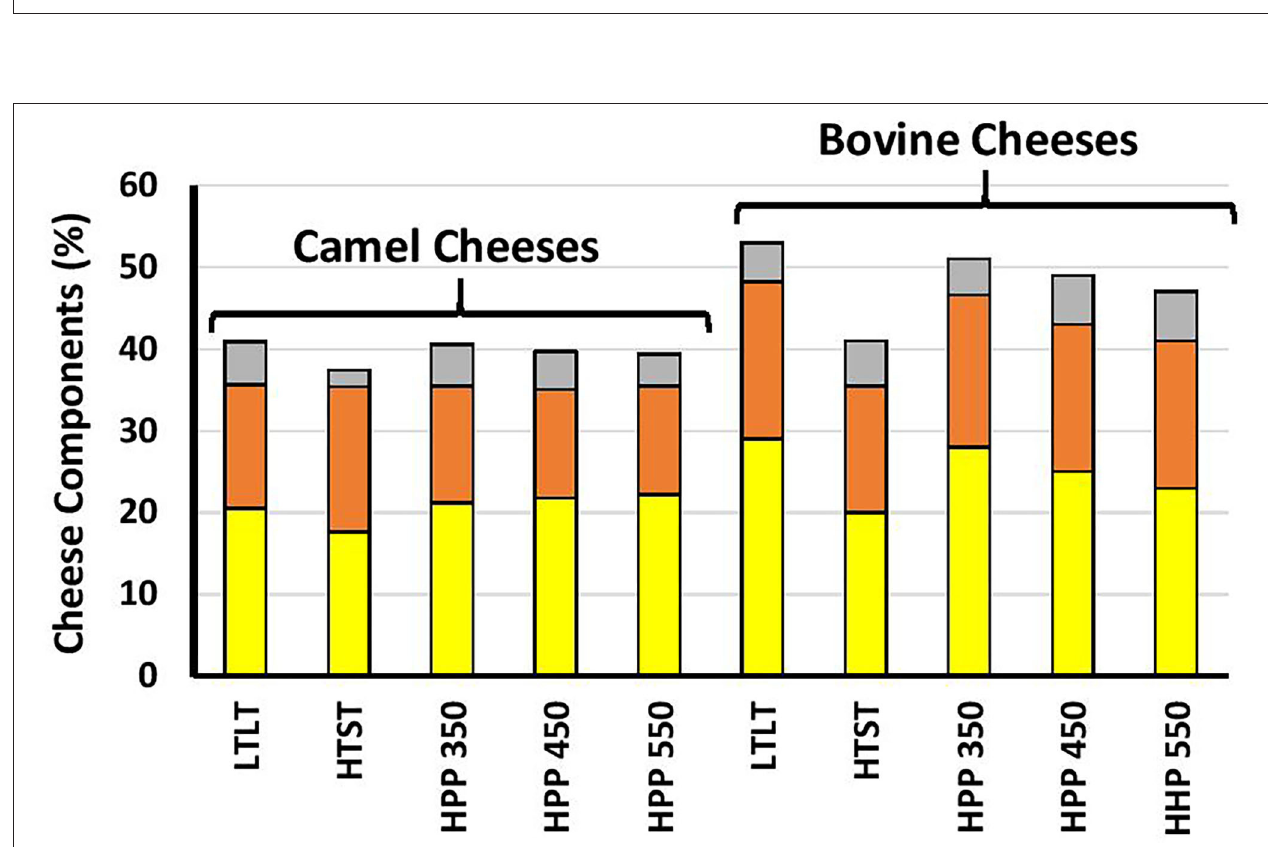
FIGURE 3 | The percentages of fat (yellow), protein (orange), and other solids.